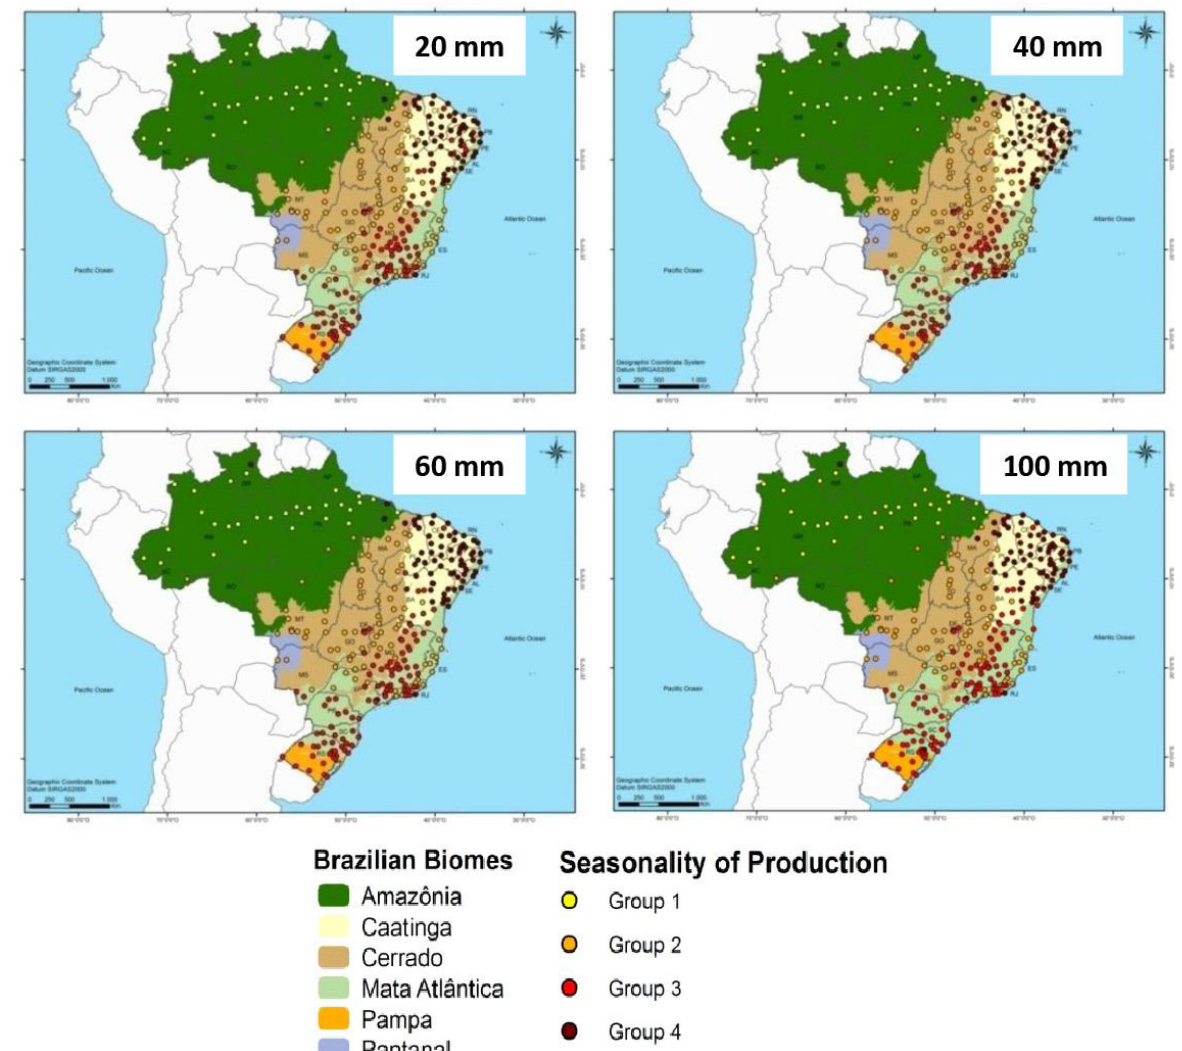
Figure 2. Classification and distribution of meteorological stations in Brazil according to cluster analysis. Cluster analysis was done according to Marandu palisade grass herbage accumulation rate mean and standard deviation in each season of the